Question: In a single sentence, describe what this figure presents.
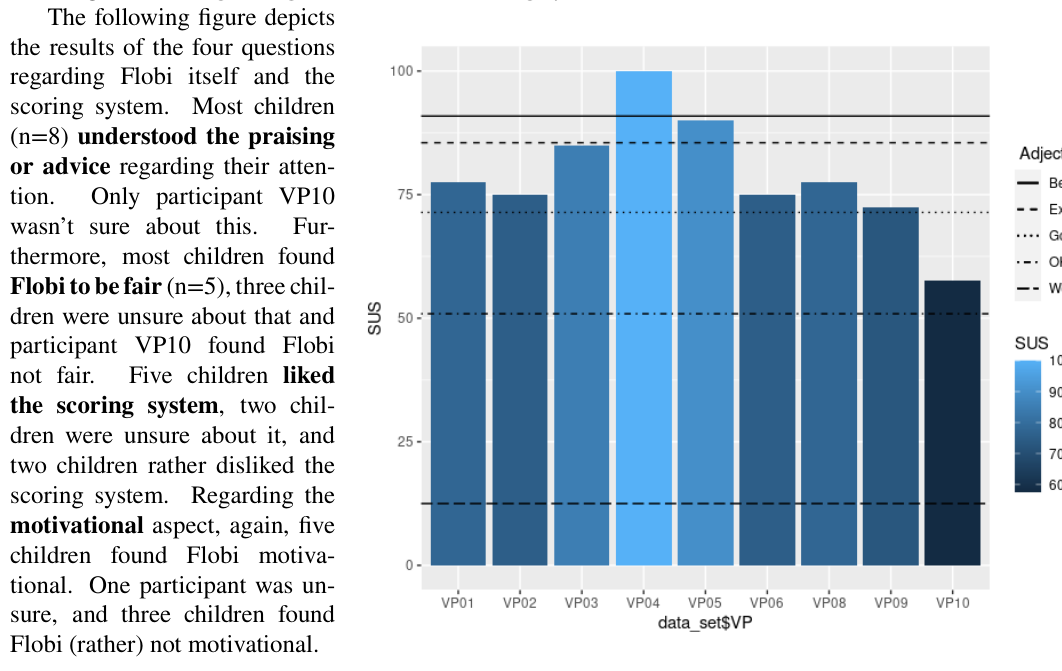
Answer: The system usability scale for each participant.